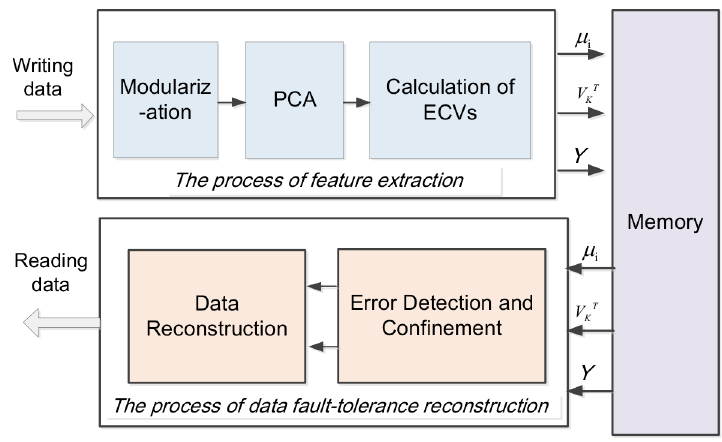
Figure 1. The overall block diagram of error confinement technique based on